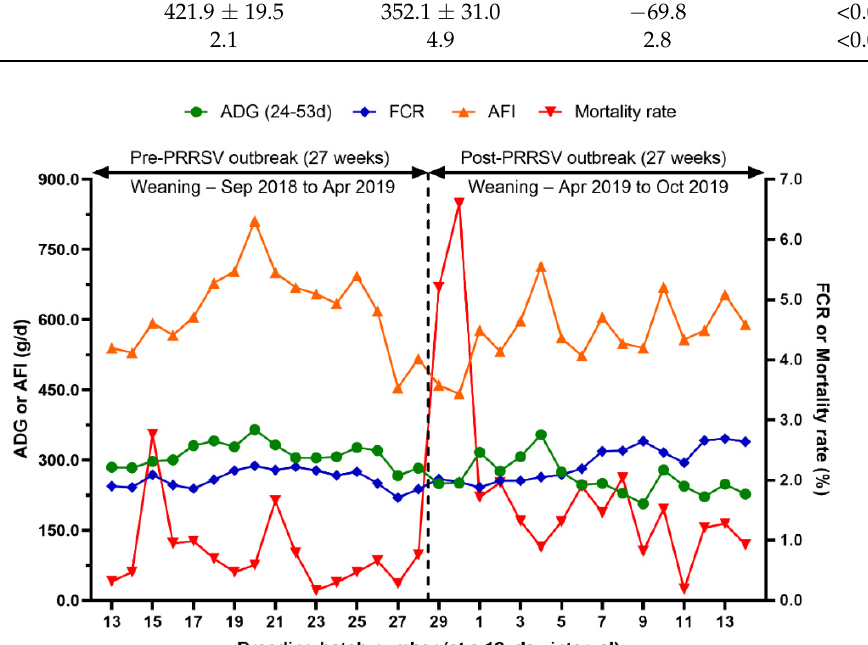
Figure 6. Comparison of average daily gain (ADG), feed conversion ratio (FCR), average feed intake (AFI) and mortality rate from 24 to 53 days of age before and after a PRRS outbreak.